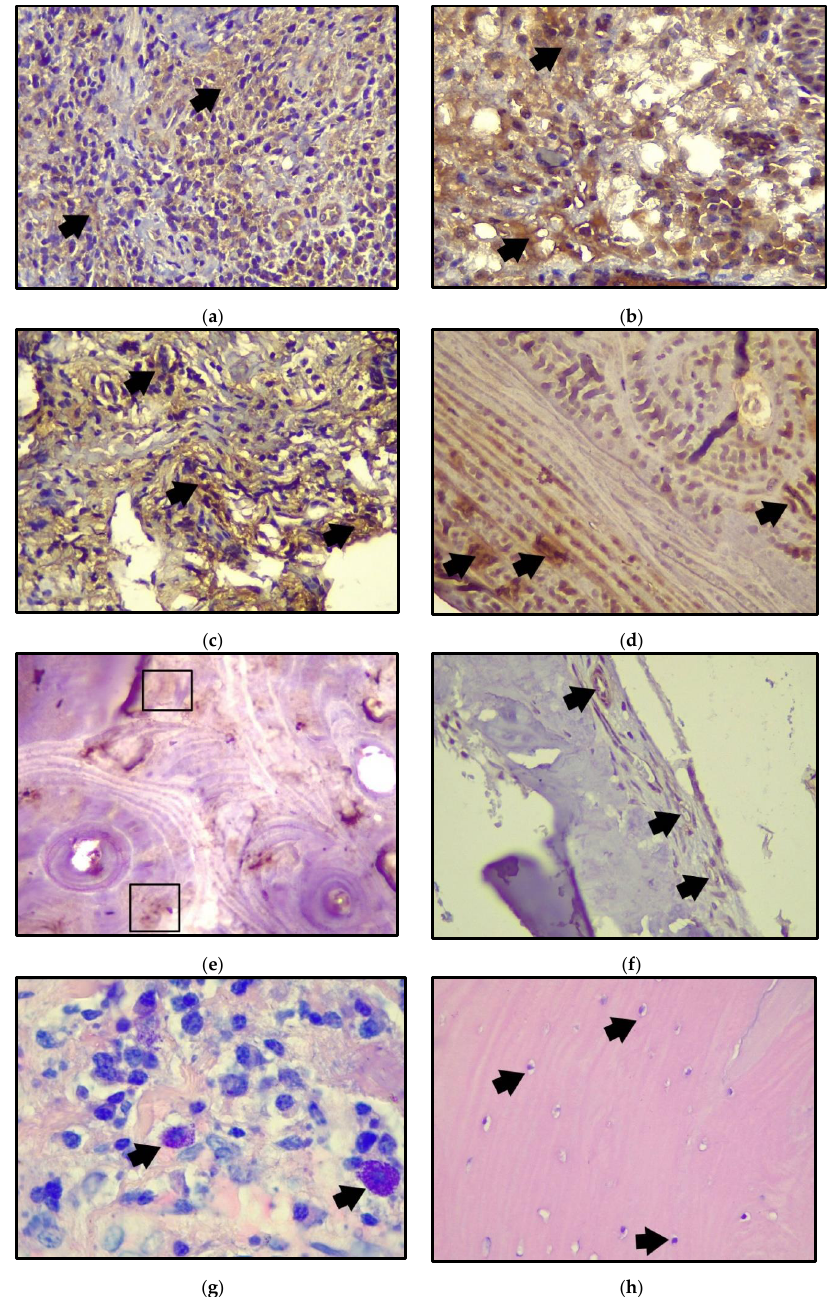
Figure 1. Histological samples of soft and peri-implant bone tissue with peri-implantitis. ( a ) Repre- sentative immunohistochemical images for APRIL in peri-implant soft tissue (40 × ) (black arrows); ( b ) immunohistochemistry for BAFF in peri-implant soft tissue (40 × ) (black arrows); ( c ) APRIL immunostaining in peri-implant bone tissue with peri-implantitis (40 × ) (black arrows); ( d ) immunos- taining of BAFF in peri-implant bone tissue (40 × ) (black arrows); ( e ) osteonectin immunostaining in peri-implant bone tissue (40 × ) (Boxes); ( f ) α -SMA immunostaining in peri-implant bone tissue (40 × ) (black arrows); ( g ) mast cells in connective tissue in peri-implant soft tissue (Giemsa, 100 × ) (black arrows); ( h ) osteocytes in peri-implant bone tissue marked in black arrows (40 ×